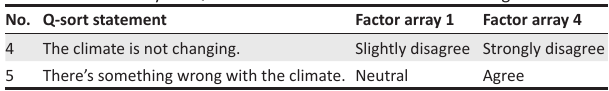
TABLE 4: Factor arrays of Q-sort statements related to climate change awareness.